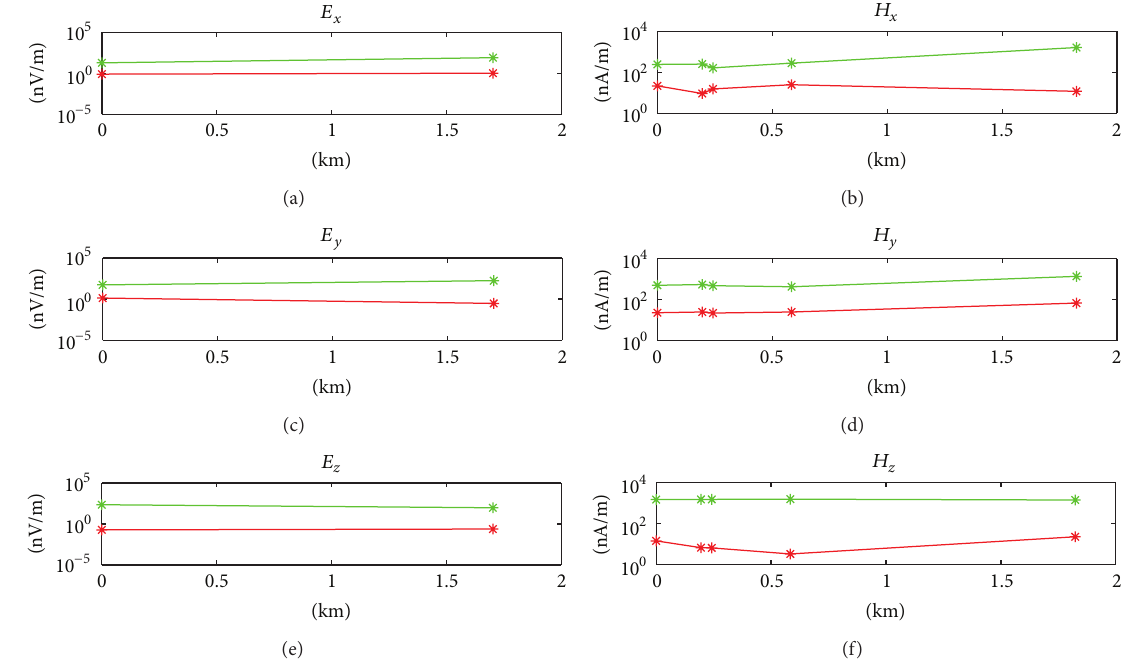
Figure6:Amplitudesofthefieldcomponents(reducedto1Ainthesource)fortheinitialgeoelectricmodelat41 Hz(greenlines)ascompared with the observed amplitudes (red